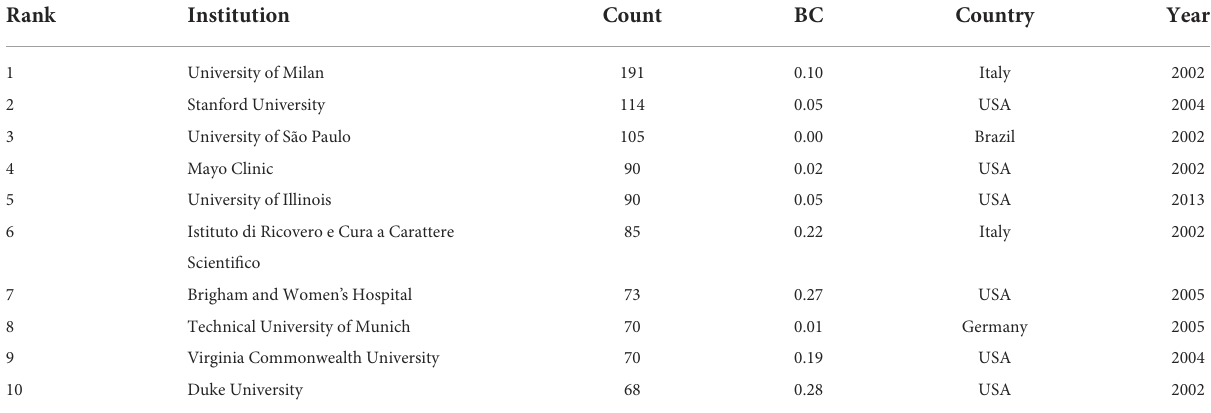
TABLE 2 Top 10 institutions based on the number of CPET publications.